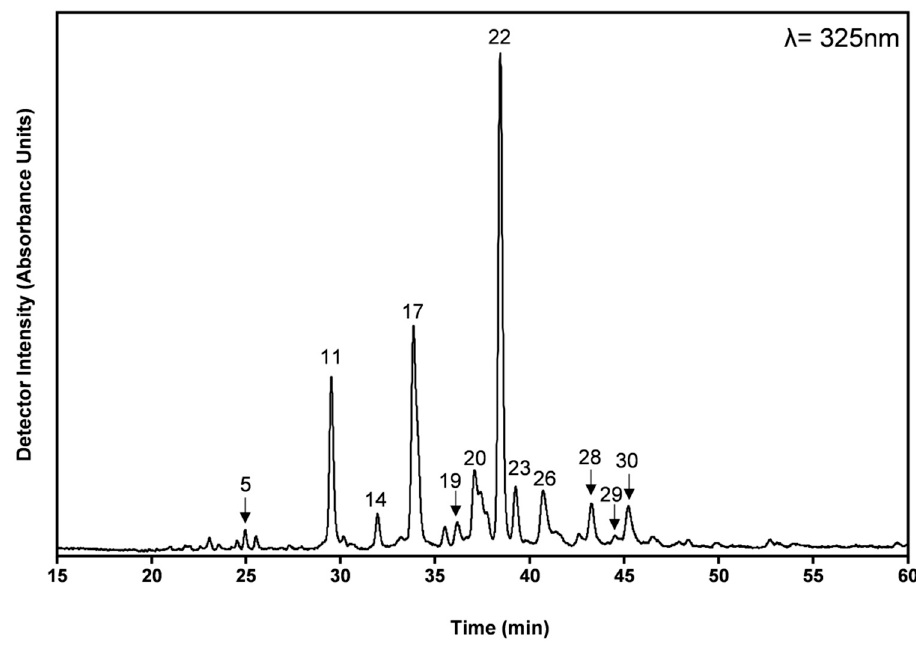
Figure 1. Phenolic profile of Thymus mastichina . HPLC-DAD chromatogram of hydroethanolic extract. For peak identification, please refer to Table 2.